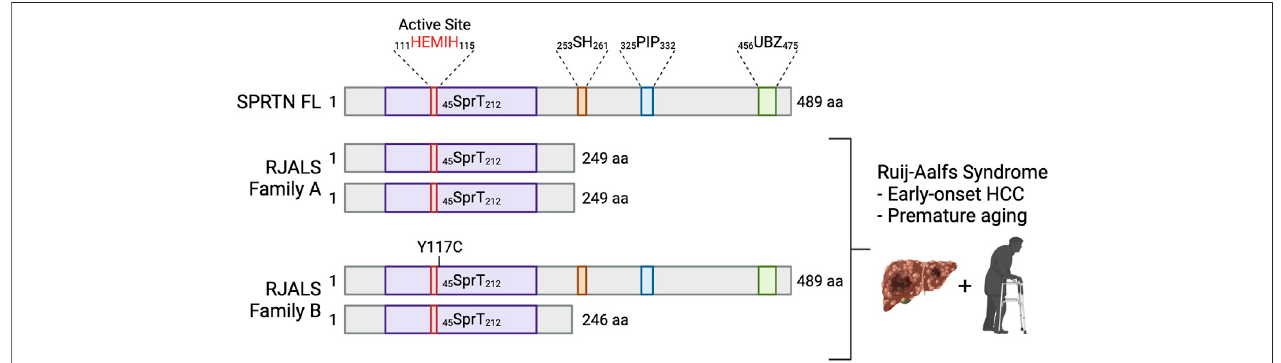
FIGURE 4 | Mutations in SPRTN cause Ruijs-Aalfs syndrome. Schematic depicting SPRTN protein products resulting from biallelic mutations identi fi ed in RJALS patients. Family A mutants resulted in a premature STOP codon and SPRTN truncation at aa 249 (SPRTN Δ C). Family B compound heterozygous mutations resulted in aa substitution at tyrosine 117 mutated to cysteine (SPRTN Y117C), and a premature STOP codon and truncation at aa 246. RJALS causes early-onset hepatocellular carcinoma and premature aging (Lessel et al., 2014). Created in